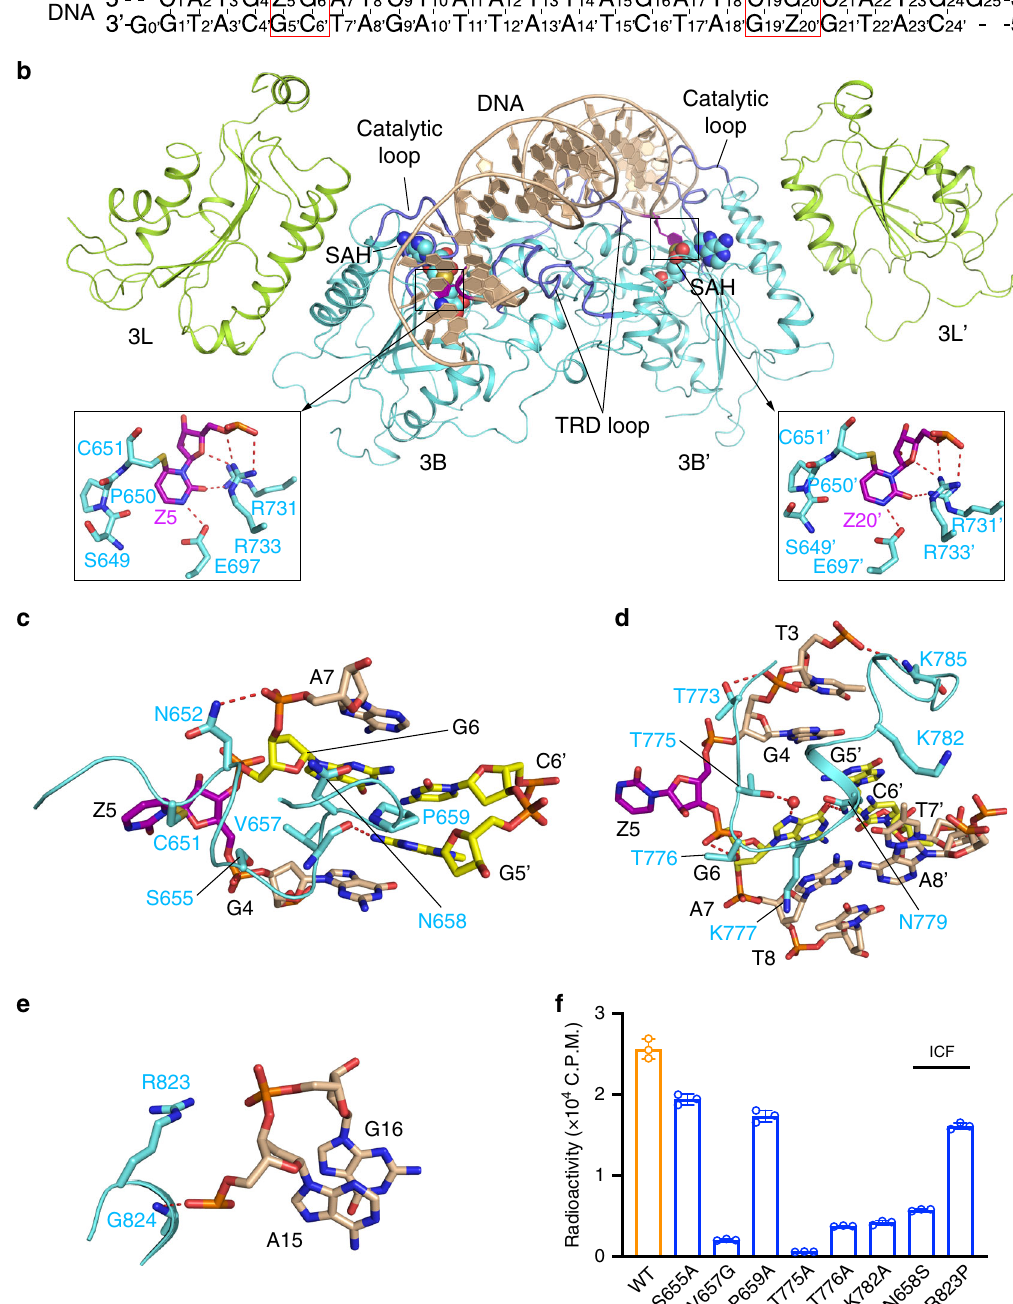
Fig. 3 Structure of the DNMT3B – DNMT3L tetramer in complex with CGA DNA. a DNA sequence (CGA) used for the structural study. Zebularine (Z) is a cytidine analog known to form stable covalent complexes with DNMTs 55 . b Ribbon representations of human DNMT3B – DNMT3L bound to DNA and SAH. The DNA-contacting TRD loop and catalytic loop are colored in slate. The Zebularines anchored at the two active sites are shown in expanded views, with hydrogen-bonding interactions depicted as dashed lines. For identi fi cation of hydrogen bonds, the upper limit of the donor – acceptor distance was set to 3.5 Å. c – e Close-up views of the DNA interactions of the catalytic loop b , TRD loop c , and the loop at the RD interface d of DNMT3B. The DNA is colored in wheat, except for the ZpG site, in which the Zebularine and the other three nucleotides are colored in purple and yellow, respectively. The hydrogen- bonding interactions are shown as dashed lines. f In vitro methylation of wild-type (WT) and mutant DNMT3B in the form of DNMT3B – DNMT3L tetramer analyzed by radioactive methylation assays ( n = 3 replicates). Data are mean ± SD. Source data are provided as a Source Data fi